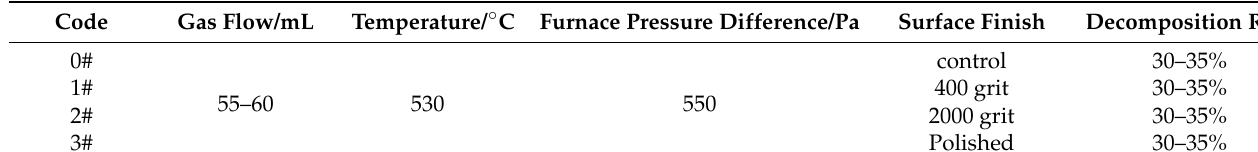
Table 2. The parameters of in situ gaseous nitriding process (Holding time 3 h).